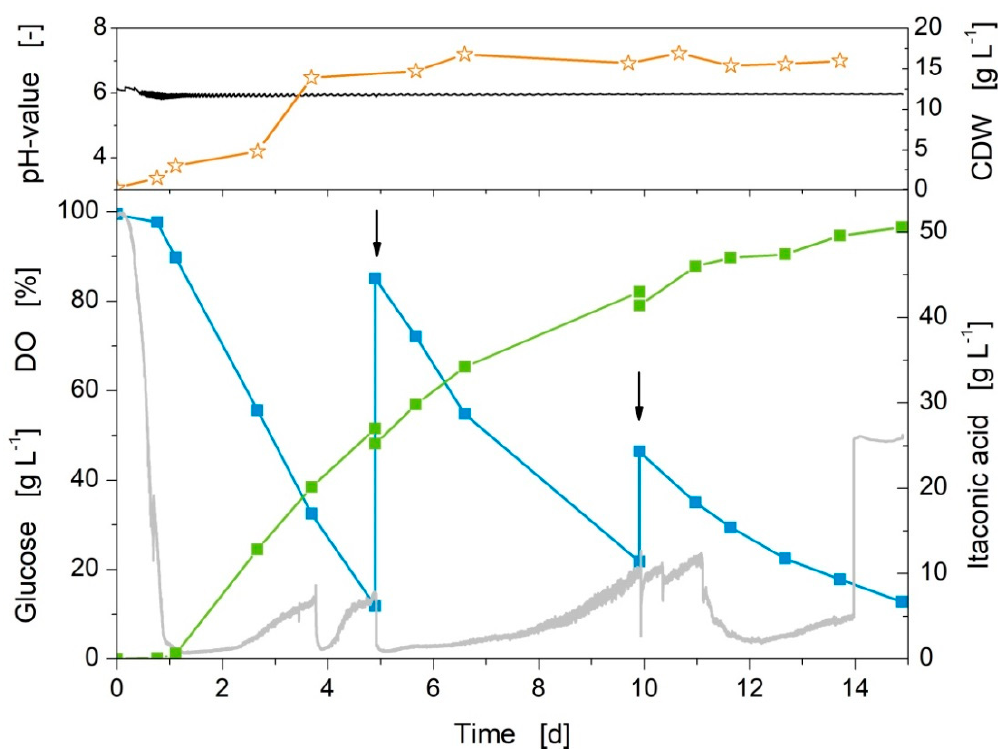
Figure 4. Fed batch with glucose in 1 L-bioreactor with modified Tabuchi-medium (initial glucose concentration 100 g·L − 1 and 1.5 g·L − 1 yeast extract) at 30 °C, 500 rpm, 0.1 vvm, pH 6.0 with 4 M NaOH as base and 1% ( v/v ) inoculum. Glucose (blue square), itaconic acid (green square), pO 2 (grey line), pH (black line), cell dry weight (CDW) (orange asterisk), arrows symbolize the addition of glucose.